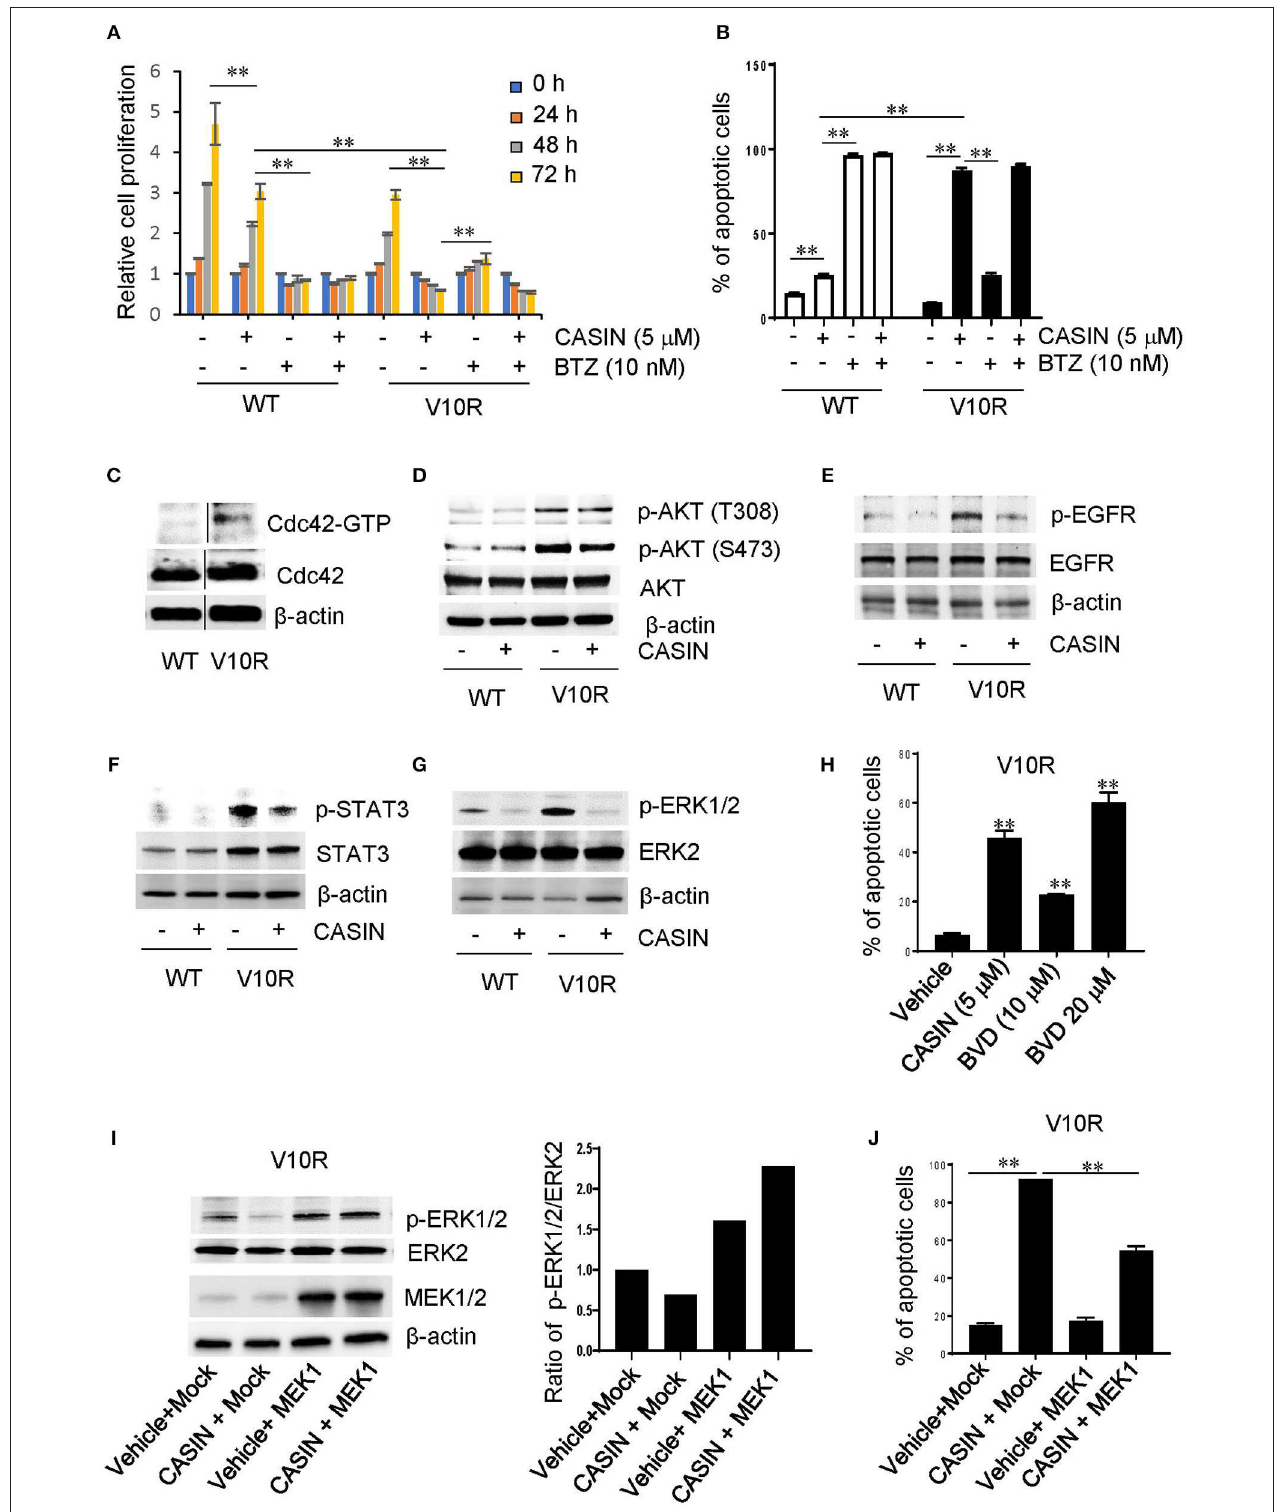
FIGURE 4 | Effects and mechanism of action of CASIN in bortezomib-resistant MM cells. (A) CASIN preferentially suppresses cell proliferation in bortezomib-resistant MM cells. Bortezomib-sensitive MM cells (WT) and bortezomib-resistant MM cells (V10R) were treated with or without CASIN (5 µ M), bortezomib (BTZ) (10nM) for